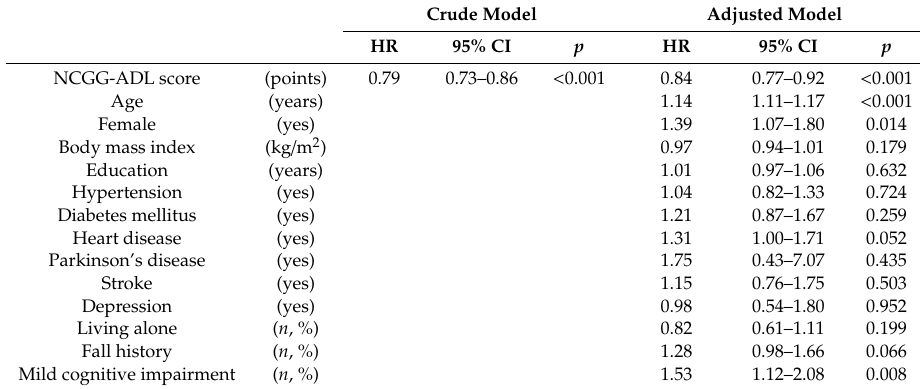
Table 2. Hazard ratios and 95% confidence intervals for disability incidence in the crude and adjusted models for 24 months per the raw NCGG-ADL score ( N =